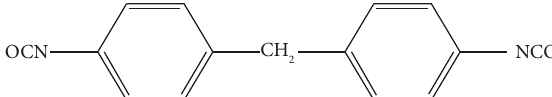
Figure 2: Chemical structure of MDI.